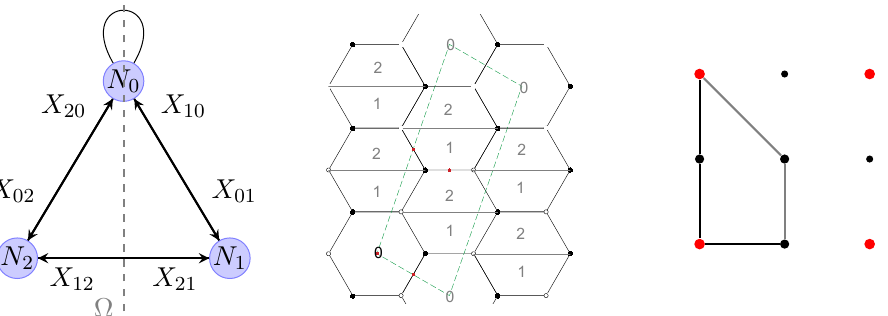
Figure 30. The various unoriented descriptions of the SPP: the quiver, the dimer with the four (cid:12)xed points in red, and the toric diagram with toric involution corresponding to a non-compact (cid:10)7 or a non-compact (cid:10)7 and a (cid:10)3, depending on how the toric diagram is triangulated.